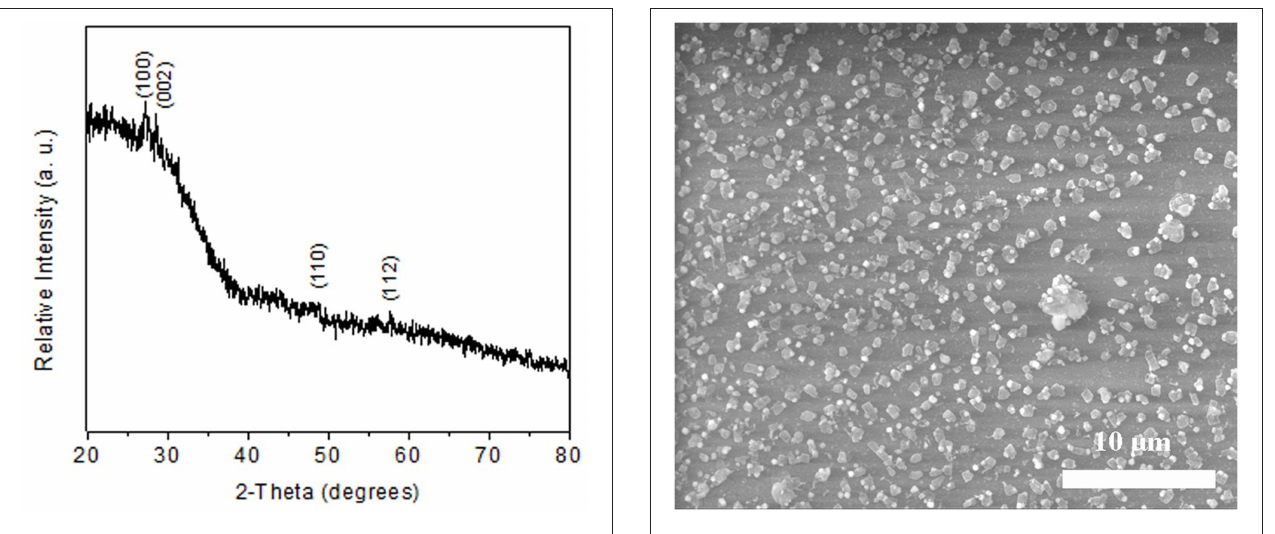
FIGURE 5 | SEM image of ZnS thin film obtained using AACVD of ZnCl 2 (cinnamtsczH) 2 450 ◦